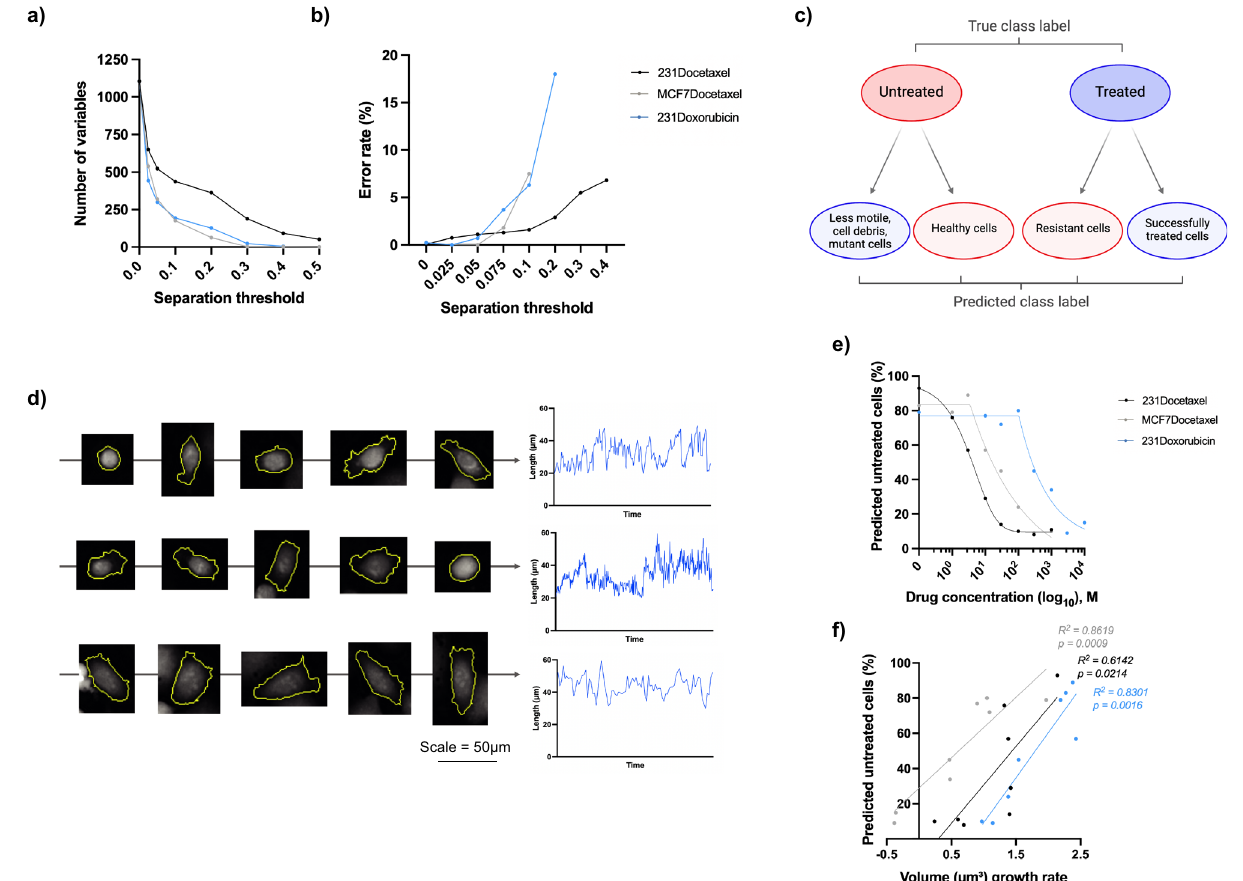
Fig. 5 | Analysis of misclassi fi ed cells. a The number of variables with separation scores above different thresholds. A greater number of variables achieve high separationfor231Docetaxelincomparisonto231DoxorubicinandMCF7Docetaxel. b Optimisation of separation threshold for each data set. Thresholds of 0.075, 0.025, and 0.025 were selected for 231Docetaxel, MCF7Docetaxel and 231Doxor- ubicin respectively resulting in 437, 539 and 442 variables being used for classi fi er training. c Sub-populations within each class, colour-coded according to the ideal fi nalclassi fi cationofeachsub-population.Non-conformingcellsforeachclassform a subset of misclassi fi ed cells. d Examples of docetaxel treated MDA-MB-231 cells